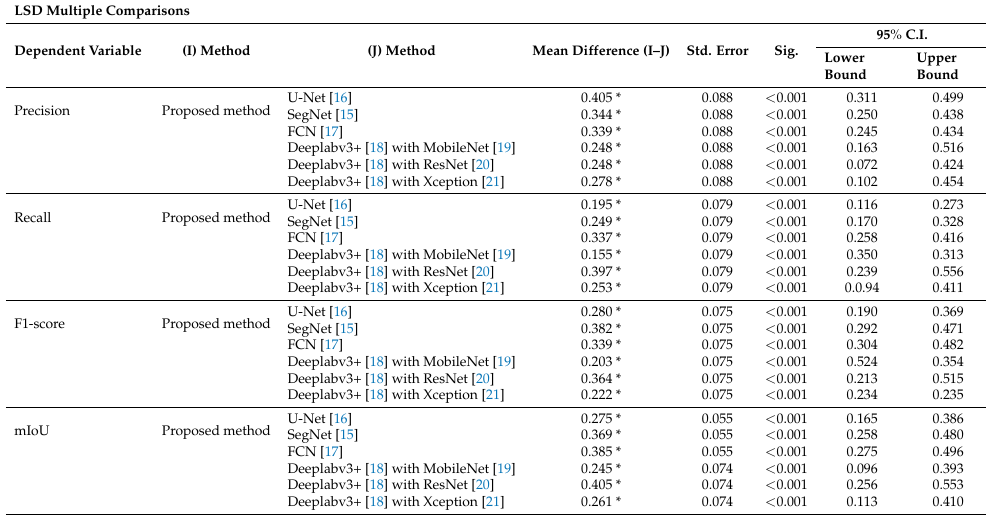
Table 2. Multiple comparisons for segmentation of metastases on H–E WSIs: LSD